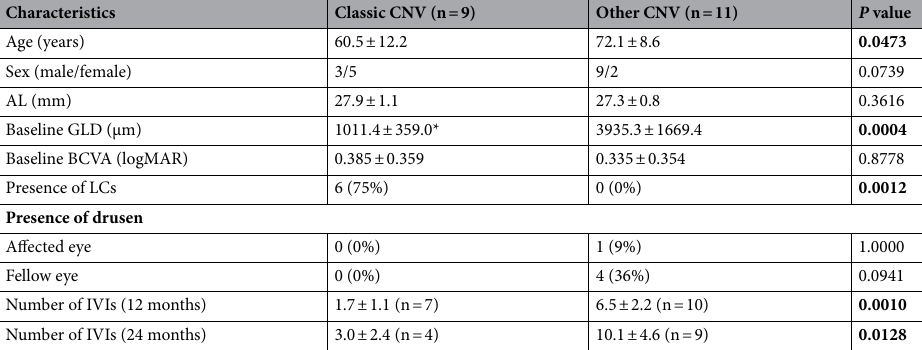
Table 2. Comparison of patient characteristics and number of intravitreous injections between classic CNV and other CNV types in patients with high-myopia CNV. The values are expressed as the mean ± standard deviation. Significant values are in bold. IVIs intravitreal injections, logMAR logarithm of the minimum angle of resolution. *Within the number of cases excluding one eye that was not performed with fluorescein angiography.